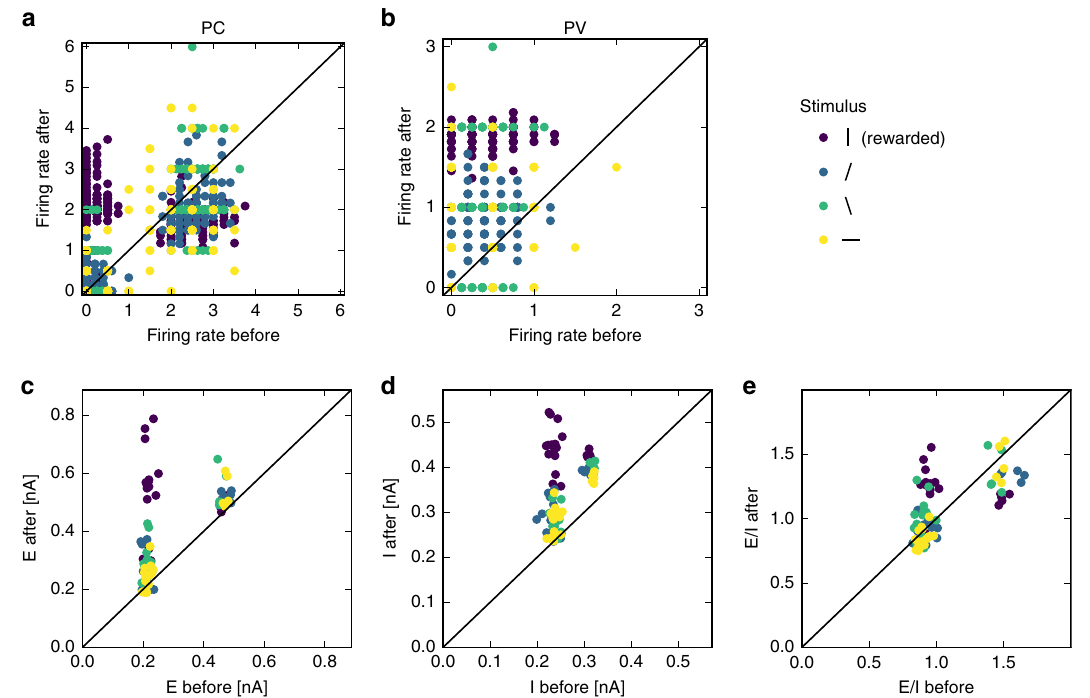
Fig. 4 Predictions of the model. a Firing rate of 20 sample excitatory neurons (5 from each population) before the rewarded phase as a function of after the re fi nement phase. b Firing rate of sample PV interneurons. c Excitatory currents (E), d Inhibitory currents (I) and e E/I ratio of the same 20 sample excitatory